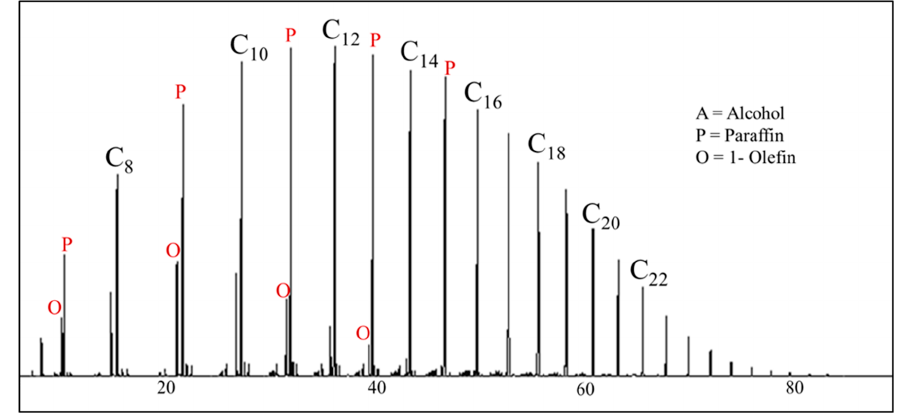
Figure 14. A chromatographic picture of an oil product from the unsupported cobalt catalyst. The x-axis is retention time in minutes. Reaction Conditions: 220 °C, 27.3 bar, WHSV = 3, and H 2 /CO = 2.